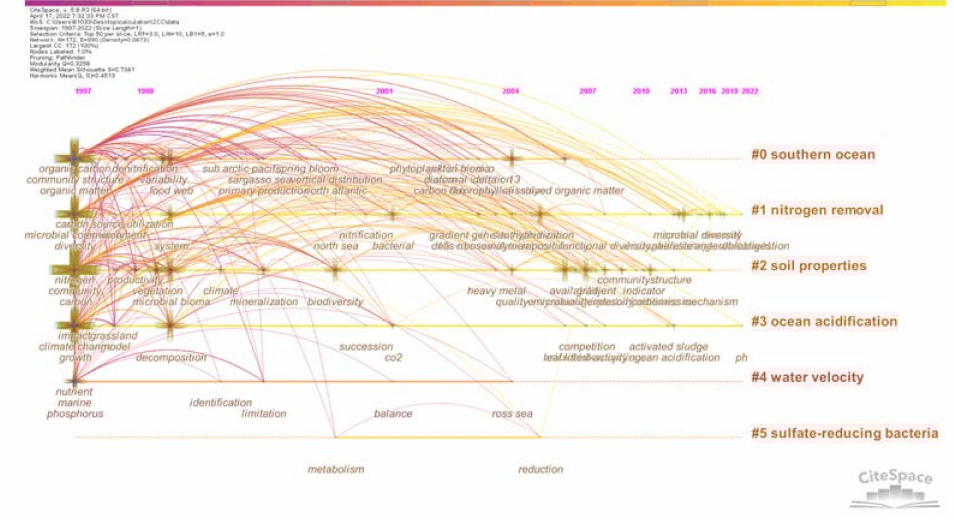
Figure 11. Timeline map of ZCC research from